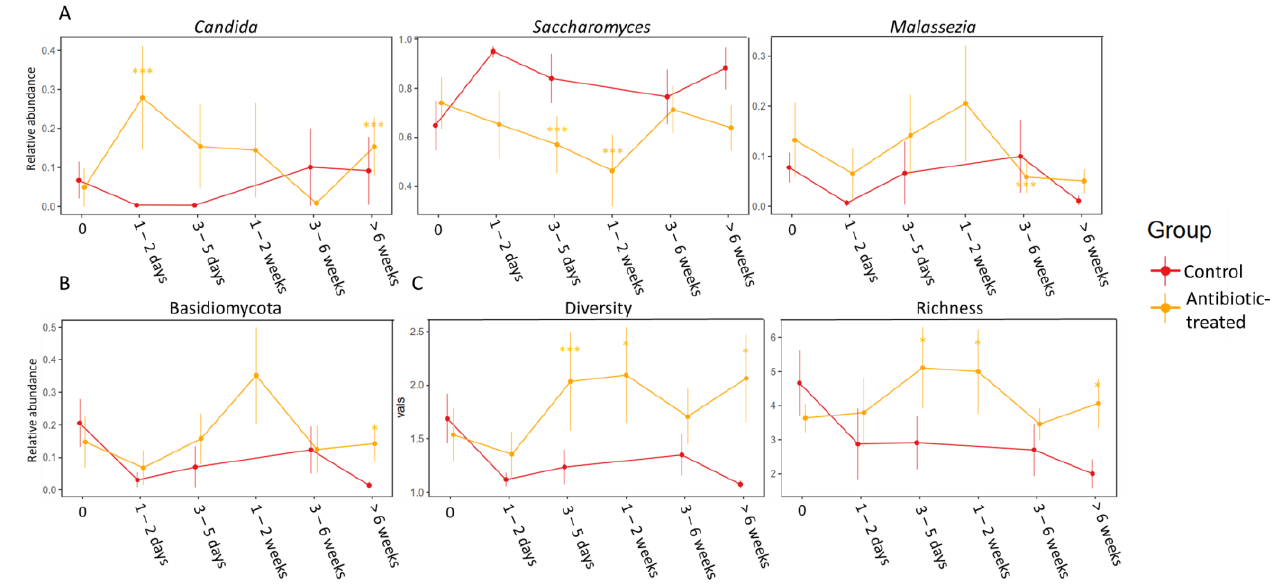
Figure 2. Differences between the control group and antibiotic-treated group over 6 timepoints starting before antibiotic treatment (marked as 0) stratified by ( A ) differences in the relative abundances at genus level, ( B ) at phylum level in the gut fungal microbiota (mycobiota), and further ( C ) differences in diversity and richness between control (red) and antibiotic-treated group (yellow). Significant p -values marked as * <0.05 and *** <0.001. All antibiotics are grouped together in the antibiotic group and for the infants who received multiple antibiotics, the timepoints are calculated as time since the most recent antibiotic. Detailed results of the statistical differences between the groups are presented in Supplementary Tables S2 – S6.